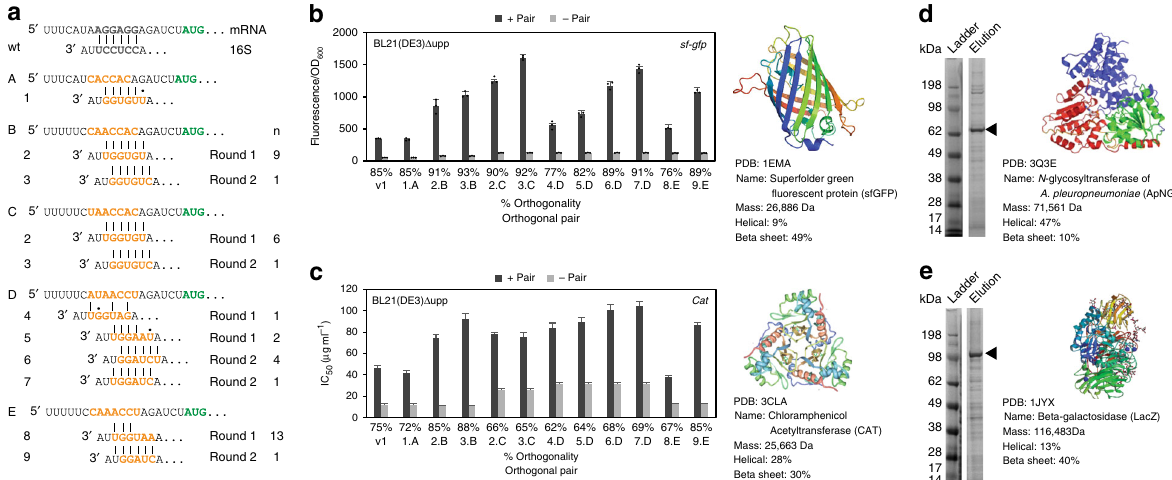
Fig. 5 Selected orthogonal pair sequences and function in Ribo-T v2. a Top evolved orthogonal mRNA and 16S with predicted pairing. Selection round is noted by round 1 or round 2 to the right of each pair. n denotes number of isolated members with that sequence from the selection. b – e Orthogonal pair notation: Original orthogonal Ribo-T system denoted by v1, and x.y where x is o16S number and y is o-mRNA letter (pORTx.y plasmid name format). b Orthogonal expression of super folder green fl uorescent protein ( sf-gfp ) in BL21(DE3) Δ upp. + pair: both o-rRNA and o-mRNA expressed, − pair: just o- mRNA expressed without cognate o-rRNA. Percent orthogonality is shown below column labels. A higher percentage value is desired, indicating a lower background expression of o-mRNA as compared to the expression with the cognate orthogonal rRNA. Error bars = 1SD of n = 3 independent experiments. The protein ’ s structure and details are listed to the right of the graph. c Orthogonal expression of Cm acetyltransferase ( cat ) in BL21(DE3) Δ upp. Error bars = 1 standard error in IC fi tting. The protein ’ s structure and details are listed to the right of the graph. d Orthogonal expression of 50 curve N -glycosyltransferase of A. pleuropneumoniae ( ApNGT ) in BL21(DE3). The protein ’ s structure and details are listed to the right of the graph. e Orthogonal expression of Beta-galactosidase (LacZ) in BL21(DE3). The protein ’ s structure and details are listed to the right of the graph. Source data for b , c can be found in the Source Data fi